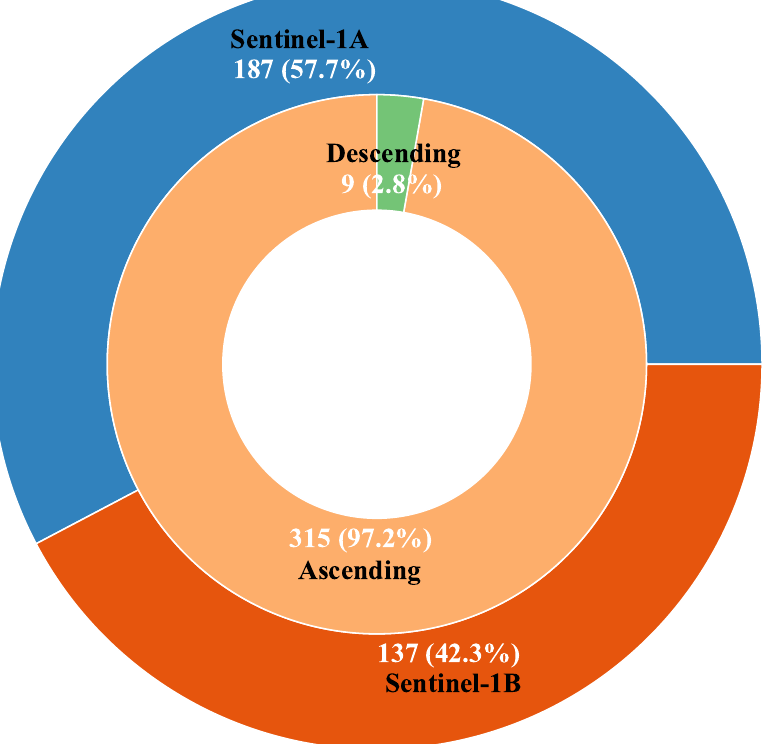
Figure 3. The number and percentage of the observations for different satellites and